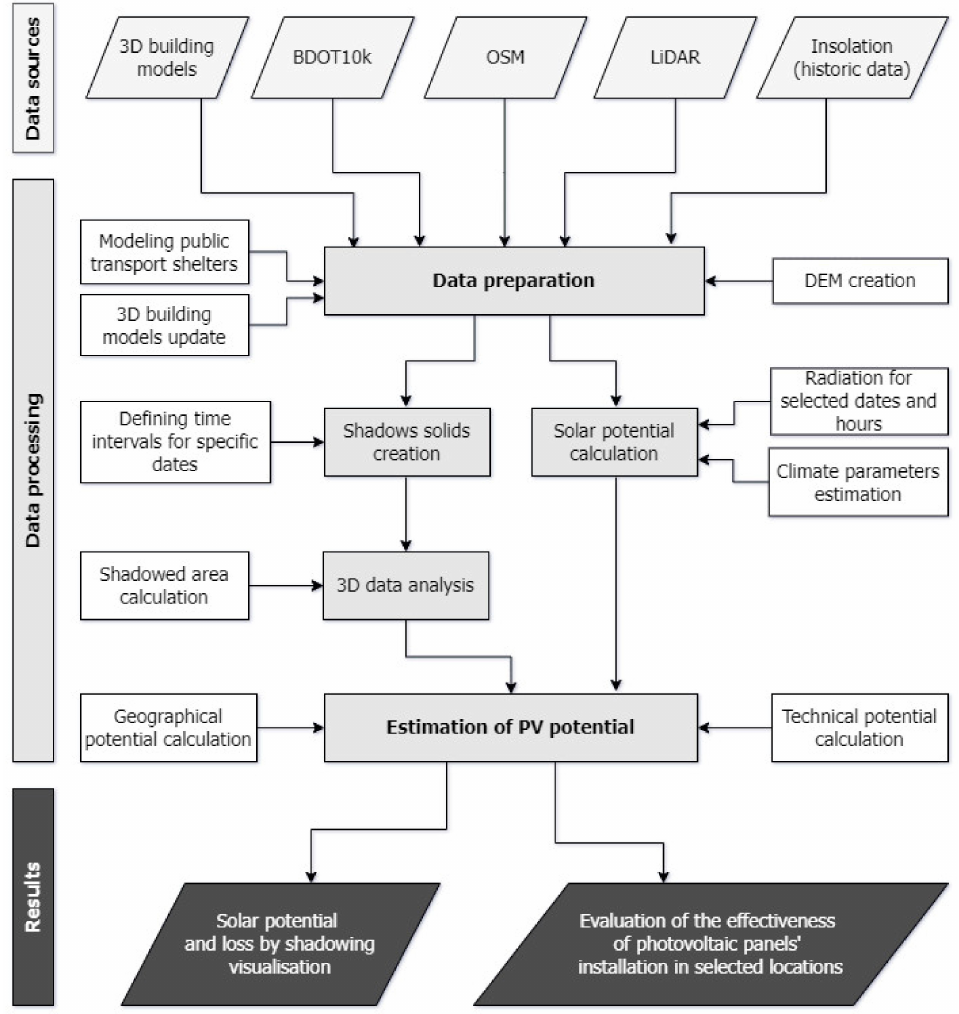
Figure 9. The scheme of the methodology showing the subsequent stages of the